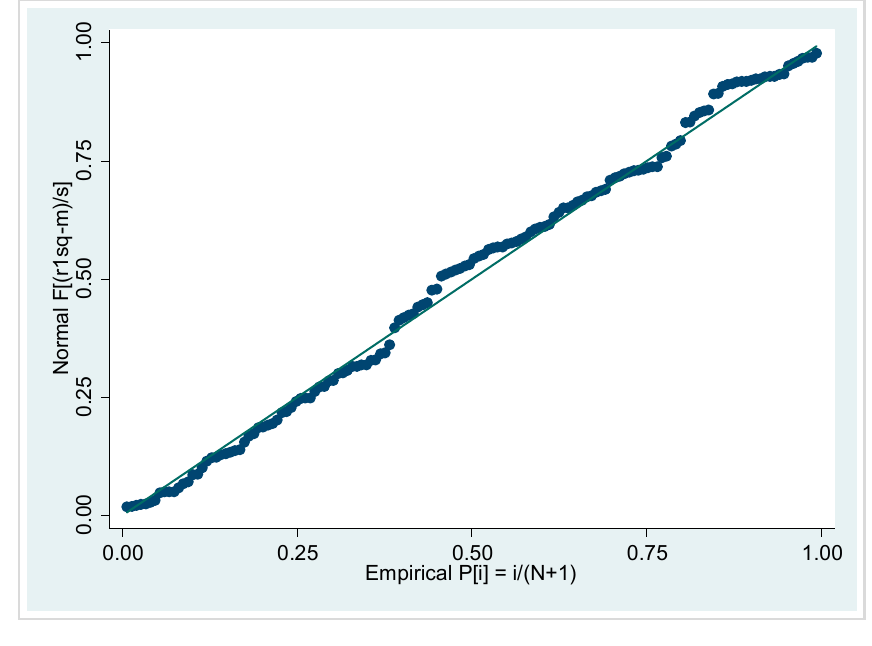
Figure 3. Normality of the residual distribution.